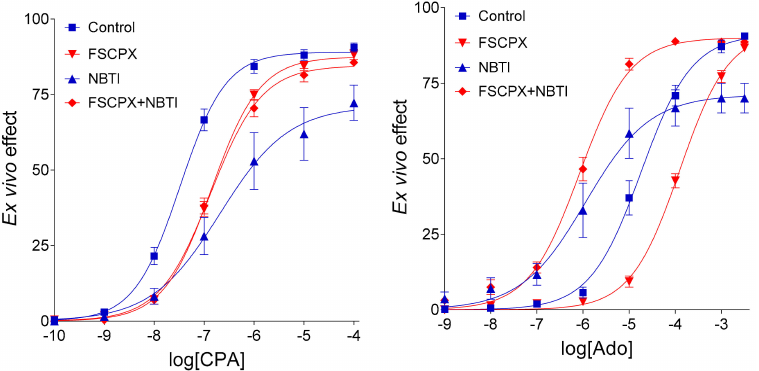
Figure 1. Concentration-response (E / c) curves of CPA, a synthetic full agonist of the A 1 adenosine receptor (having relatively long half-life, see: [15]), and adenosine, the physiological adenosine receptor full agonist (possessing very short half-life, see: [15]), where the direct negative inotropic response of isolated, paced guinea pig left atria were measured. The E / c curves illustrate the influence of NBTI, a nucleoside transport inhibitor, on the e ff ect of CPA and adenosine, without (blue curves) and with (red curves) a pretreatment with FSCPX, a chemical known as an irreversible A 1 adenosine receptor antagonist. The x -axis shows the common logarithm of the molar concentration of the given agonist (in the bathing medium), while the y -axis denotes the direct negative inotropic e ff ect (determined as a percentage decrease of the initial contractile force). The symbols show the averaged responses ( ± SEM), and the lines represent the fitted Hill equation.